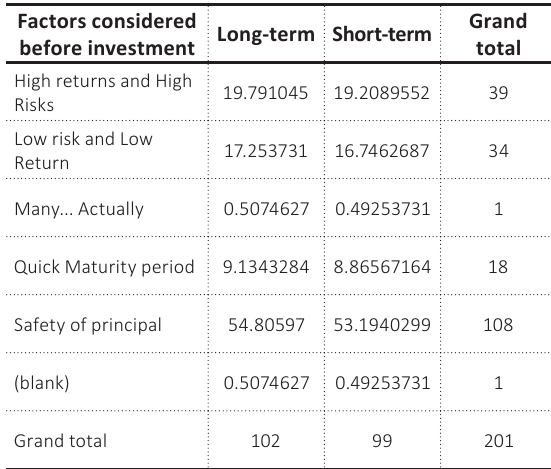
Table 8. Expected frequencies of the impact of risk and return factors considered before investment on the decisions of short and long- term investors